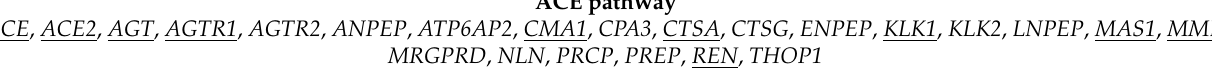
Table 1. Pathways related to renal fibrosis in KEGG *. ACE